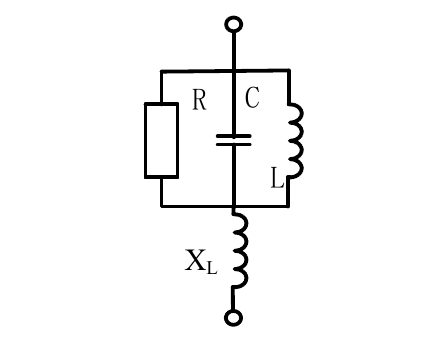
Figure 4. ( a ) Snowflake patch, ( b ) its circumcircle.